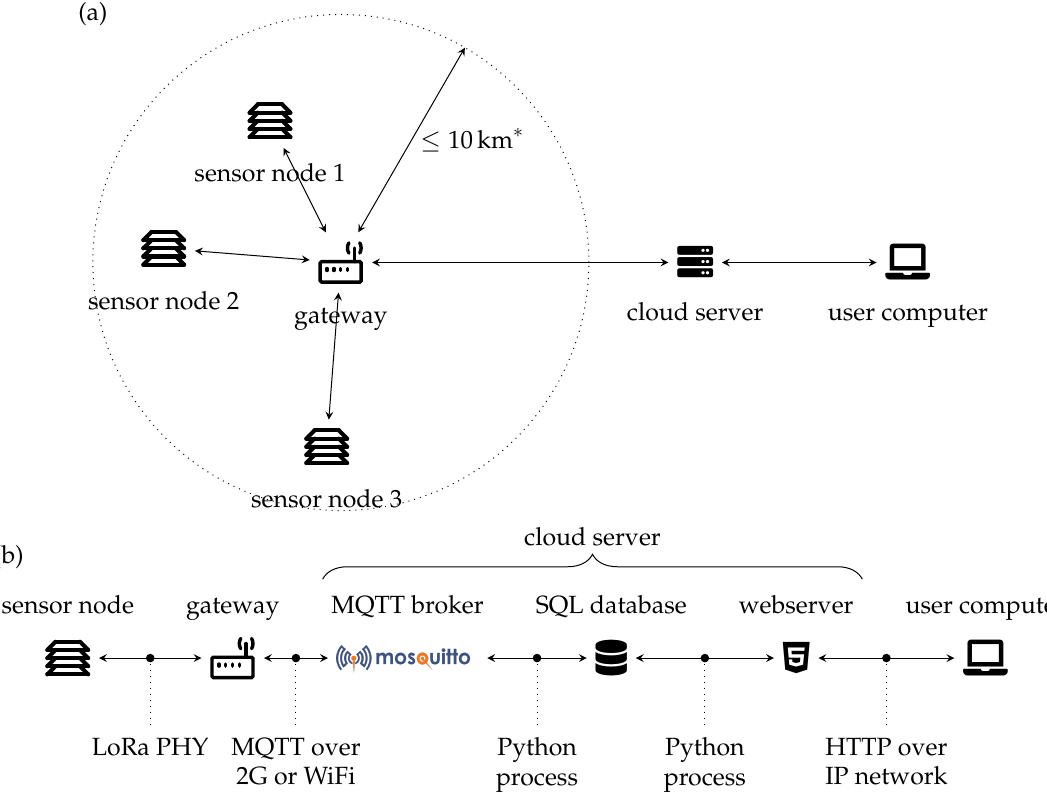
Figure 1. MIRRA network architecture and functional blocks. ( a ) Illustration of how the different components in the system communicate with each other. (*) Theoretical range indicated, actual range dependent on antenna used, location and environmental conditions. Set-up was tested up to 100m. ( b ) A functional block diagram that illustrates the different (sub)components of